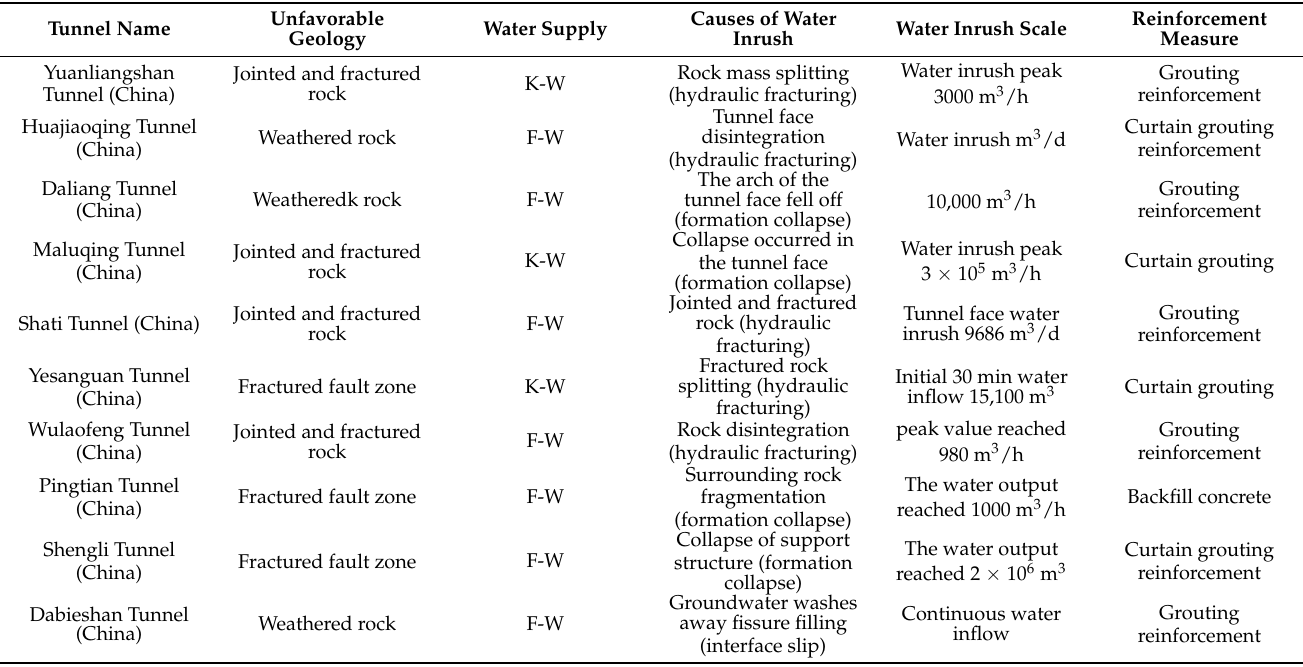
Table 1. Statistics of tunnel water hazard cases.